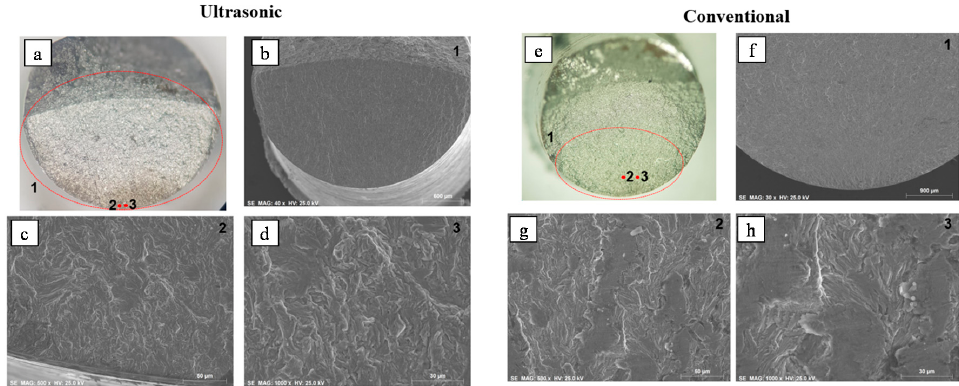
Figure 24. Uniaxial specimen after ultrasonic testing: ( a ) optical microscope general view; ( b ) SEM general view; ( c ) fatigue propagation near initiation (500×); ( d ) fatigue propagation near initiation (1000×). Uniaxial specimen after conventional testing: ( e ) optical microscope general view; ( f ) SEM general view; ( g ) fatigue propagation near initiation (500×); ( h ) fatigue propagation near initiation (1000×).